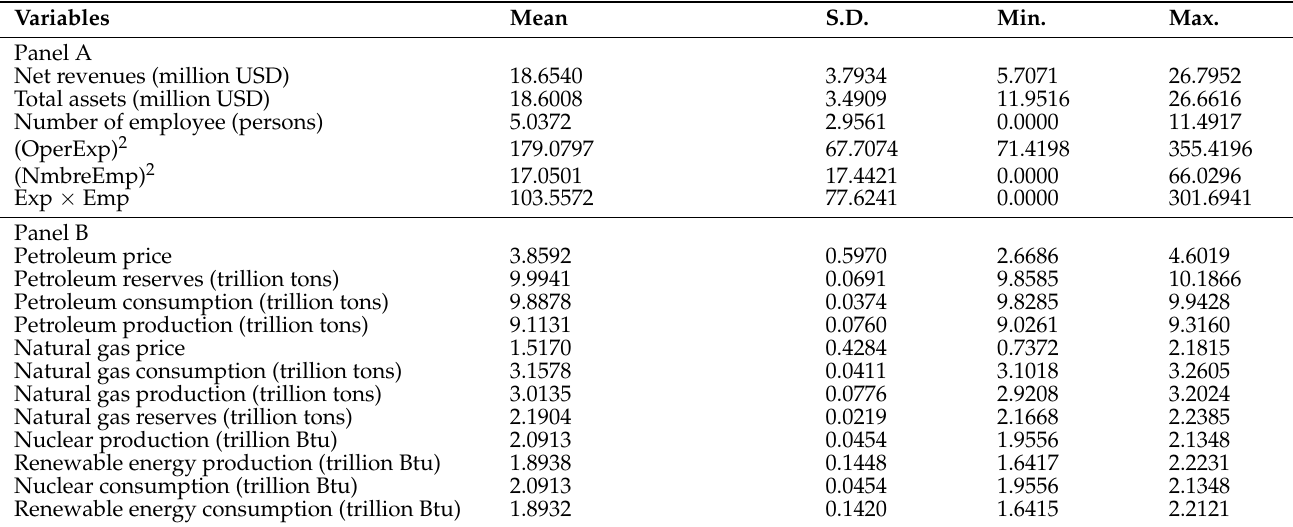
Table 1. Descriptive statistic of all used